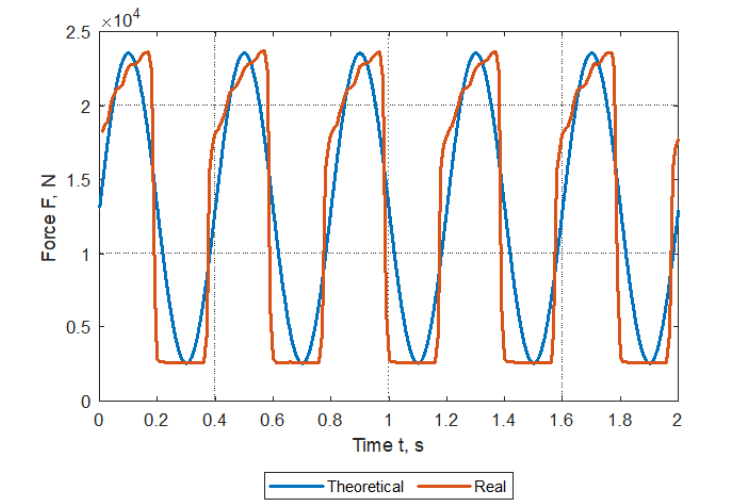
Figure 7. Load diagram in gondola fatigue